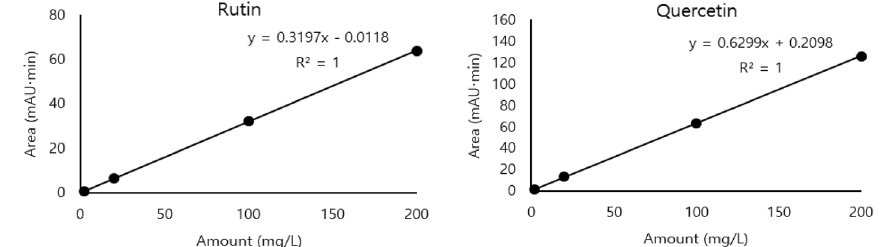
Fig.3 Standard graphs of rutin and quercetin obtained from the HPLC–DAD analysis